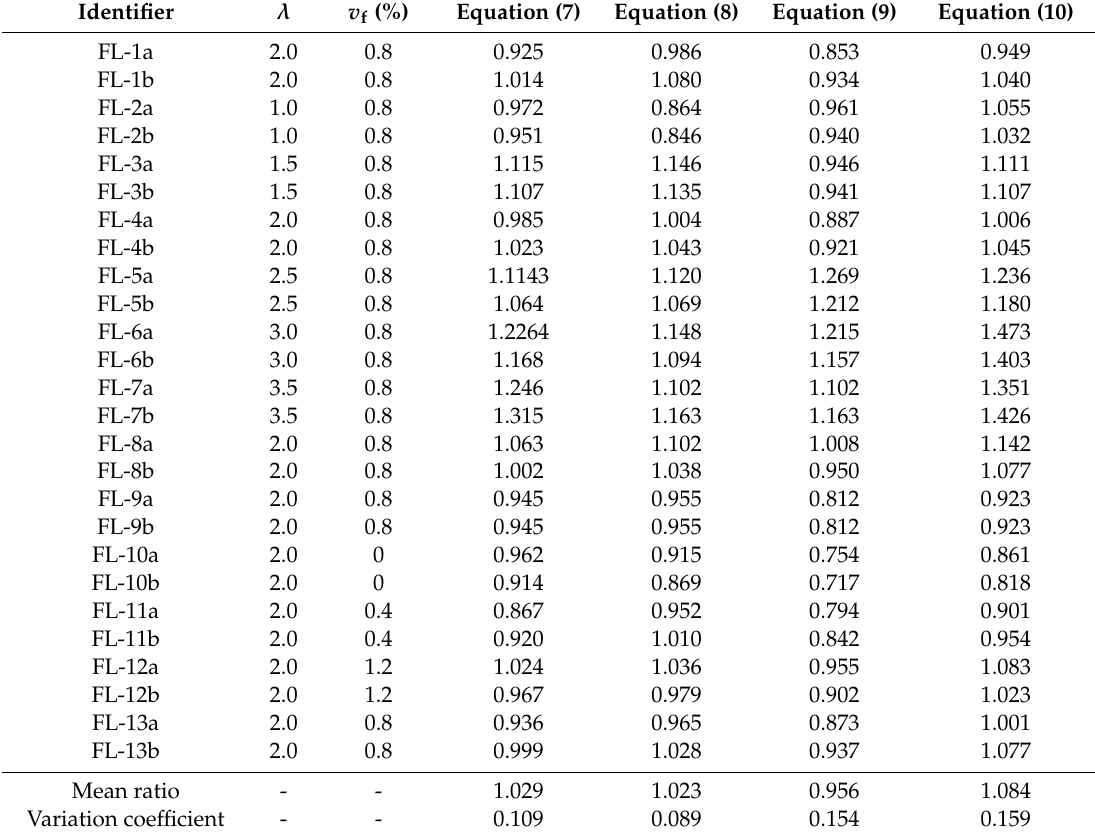
Table 2. Comparison of the ratios of the tested to calculated shear